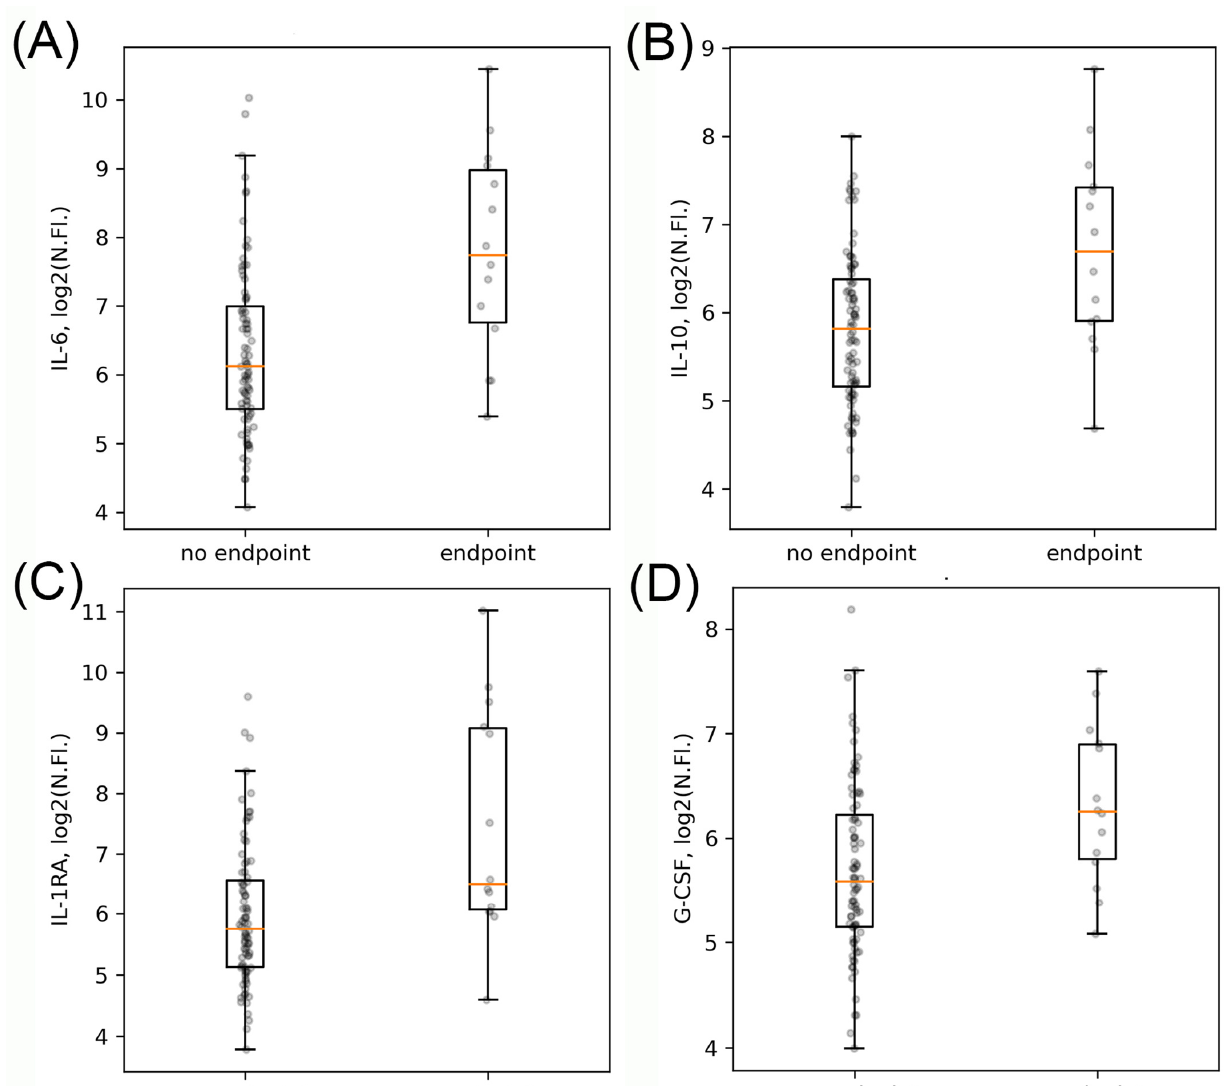
Figure 2. Boxplots for the concentrations of four cytokines prominently associated with clinical endpoints in all patients. IL-6 ( A ). IL-10 ( B ). IL-1RA ( C ). G-CSF ( D ). Data are presented as log2 of the normalized fluorescence values.